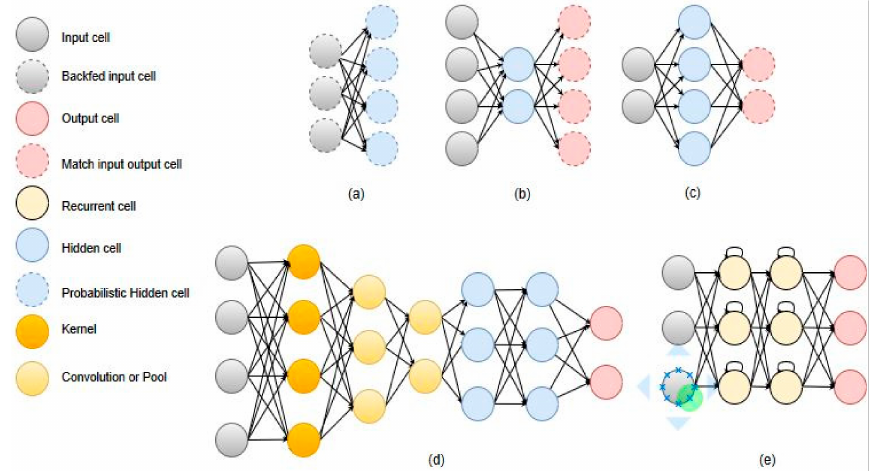
Figure 1. Graph representation of some of the commonly used architectures in medical